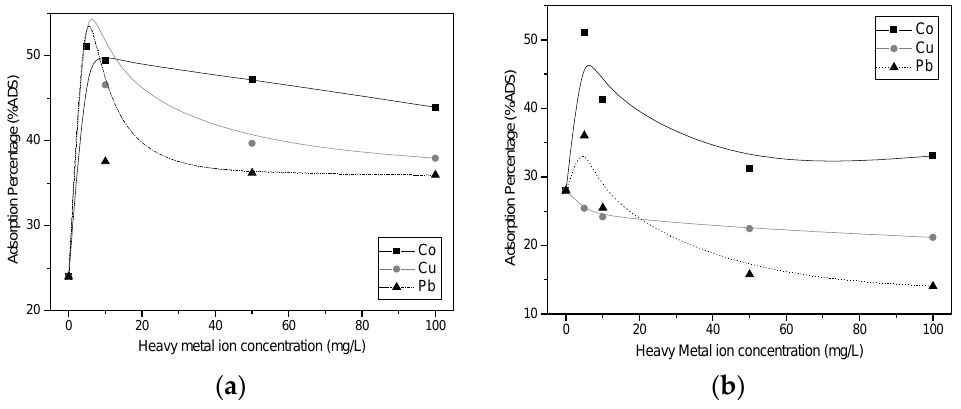
Figure 10. Effect of the presence of heavy metal ions on the adsorption of phenol onto Sargassum sp . ( a ) and Chaetomorpha ( b ). Phenol concentration 100 mg/L; Initial solution pH: 6; masses of Sargassum sp . and Chaetomorpha : 40 mg and 100 mg,